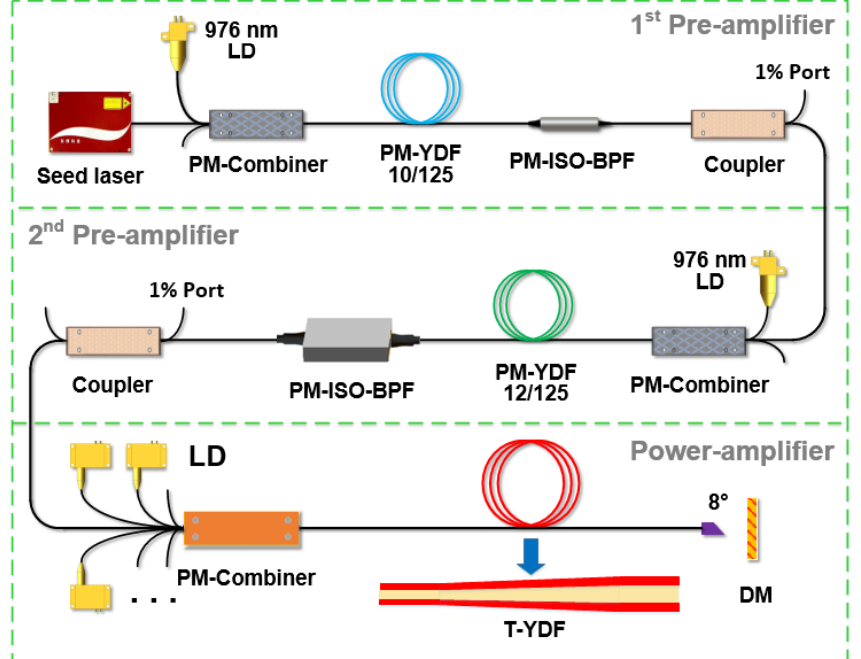
Figure 1. Experimental setup of the all-fiber single-frequency PM fiber amplifier. (PM: polarization- maintaining, LD: laser diode, YDF: Yb-doped fiber, BPF: band-pass filter, ISO: isolator, T-YDF: tapered Yb-doped fiber, DM: dichroic mirror).